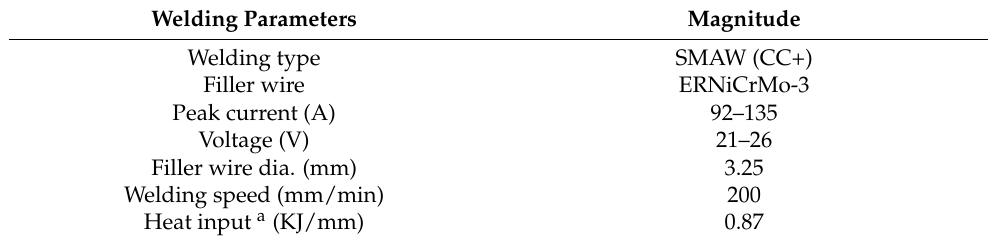
Table 2. Shielded Arc Welding parameters.